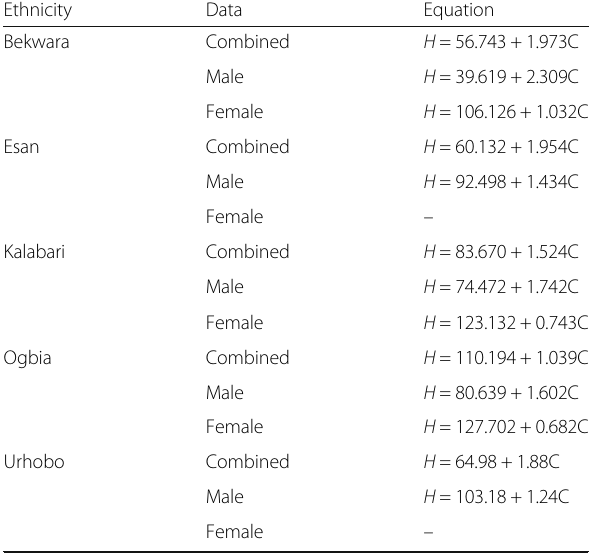
Table 8 showed the multiple regression of body height